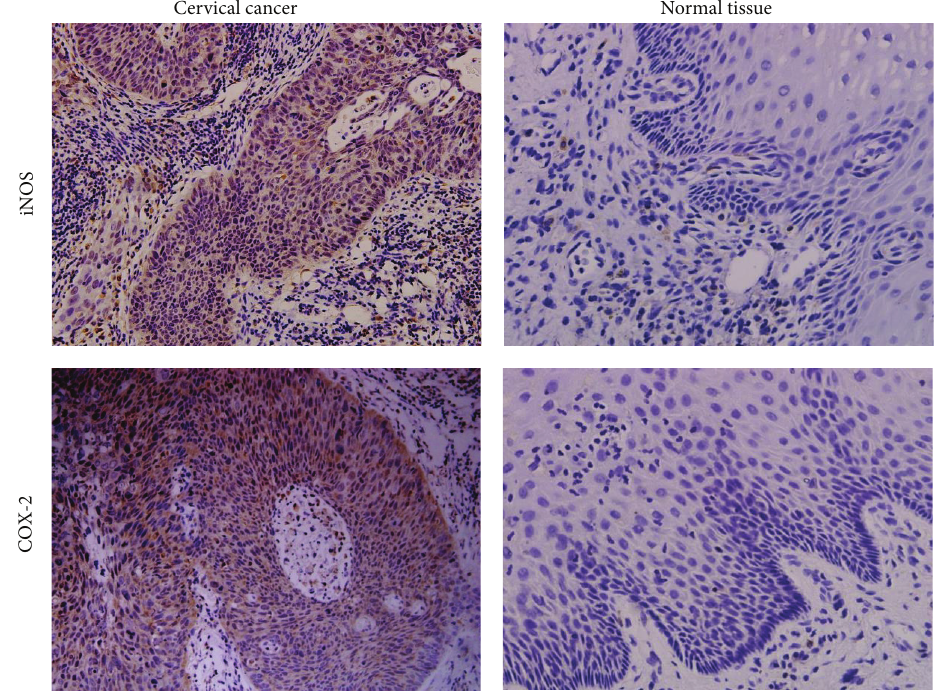
Figure 1: Expression of COX-2 and iNOS in cervical cancer tissues. Representative results of IHC assays showing the moderate/strong expression of COX-2 and iNOS in the cervical cancer tissues and the lack of expression in the normal cervical tissues. Brown color indicates positive staining for the indicted